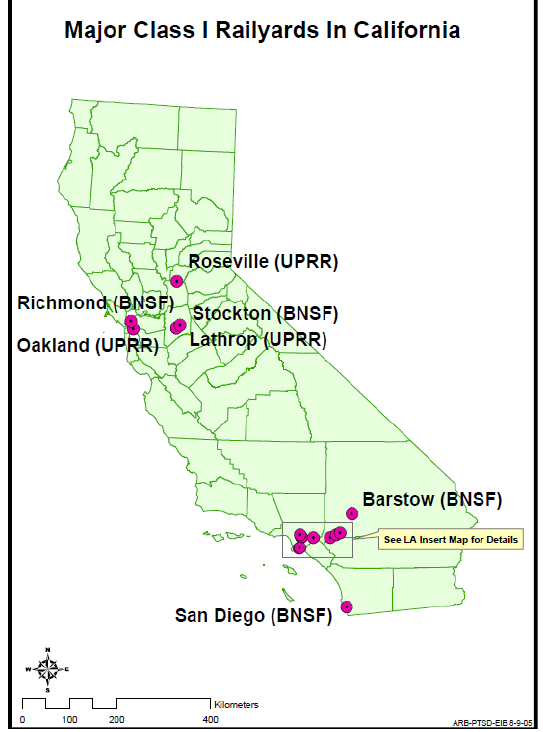
Figure 2. Map* showing locations of the 18 rail yards in California for which CARB conducted